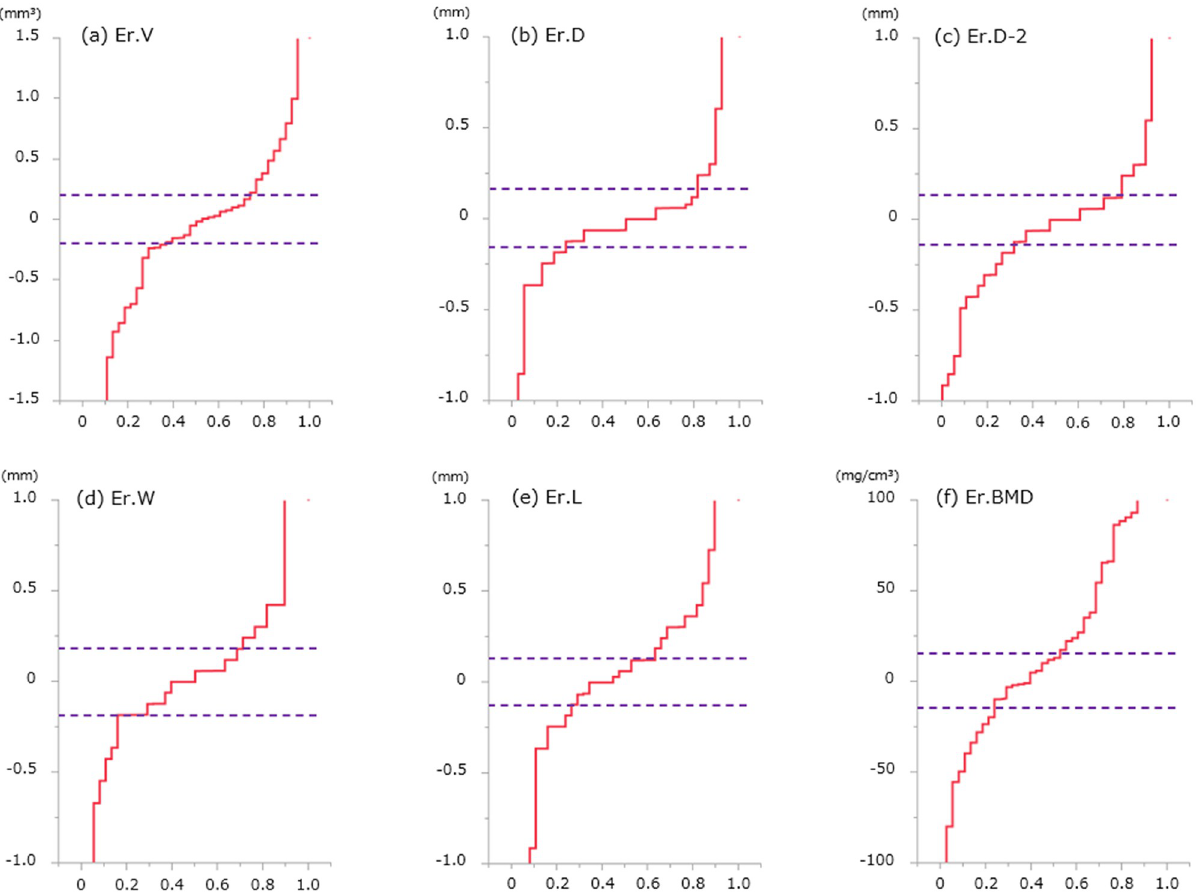
Fig 5. Cumulative probability plots regarding longitudinal changes in each erosion parameter for patients with RA. Each absolute least significant change (LSCSD) is shown as a broken line. Plots exceeding the LSC indicate significant changes on both positive and negative sides. (Er.V, erosion volume; Er.D, erosion depth in the axial view; Er.D-2, erosion depth in the perpendicular (coronal or sagittal) view; Er.W, erosion width in the axial view; Er.L, erosion length in the perpendicular view; Er.BMD, peripheral bone mineral density surrounding an